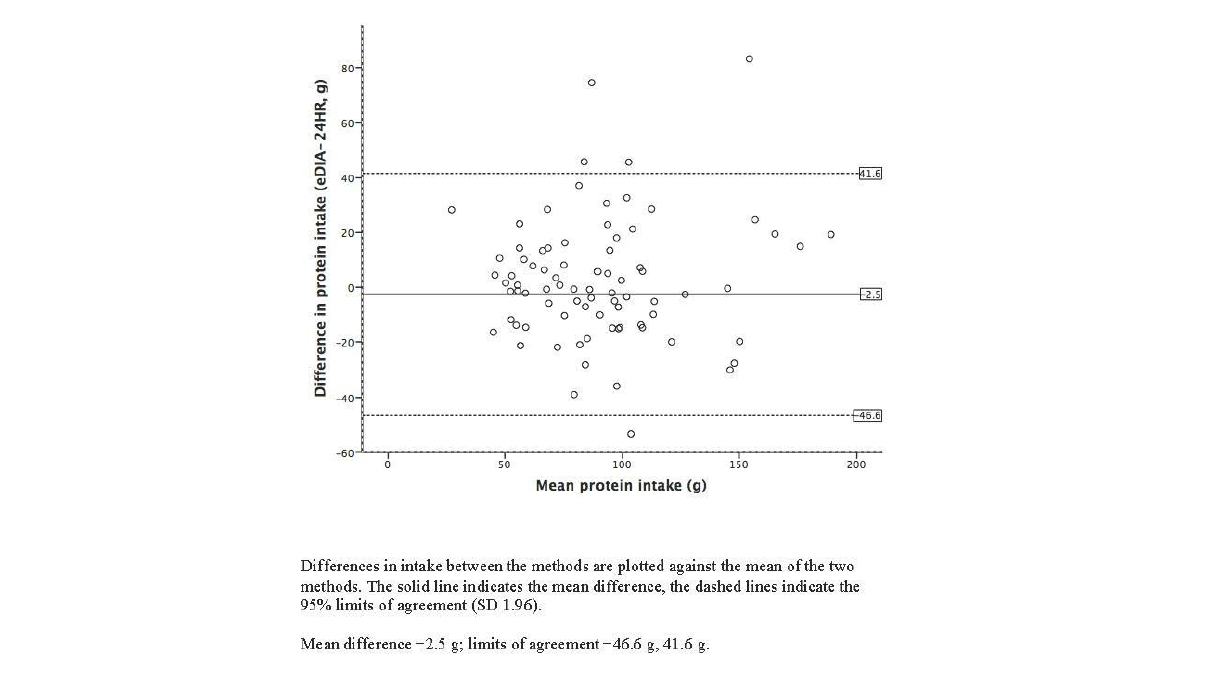
Figure 4. Bland-Altman plot of 24-hour dietary recalls (24HR) and electronic Dietary Intake Assessment (e-DIA) for protein